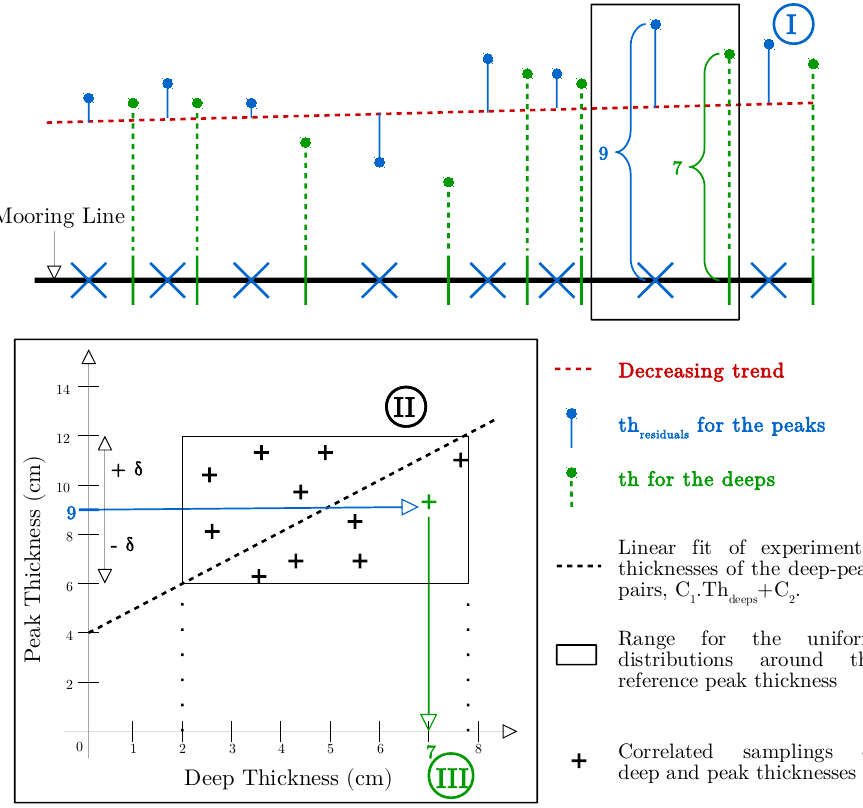
Figure A5. Overview of the generation of thicknesses for the deep